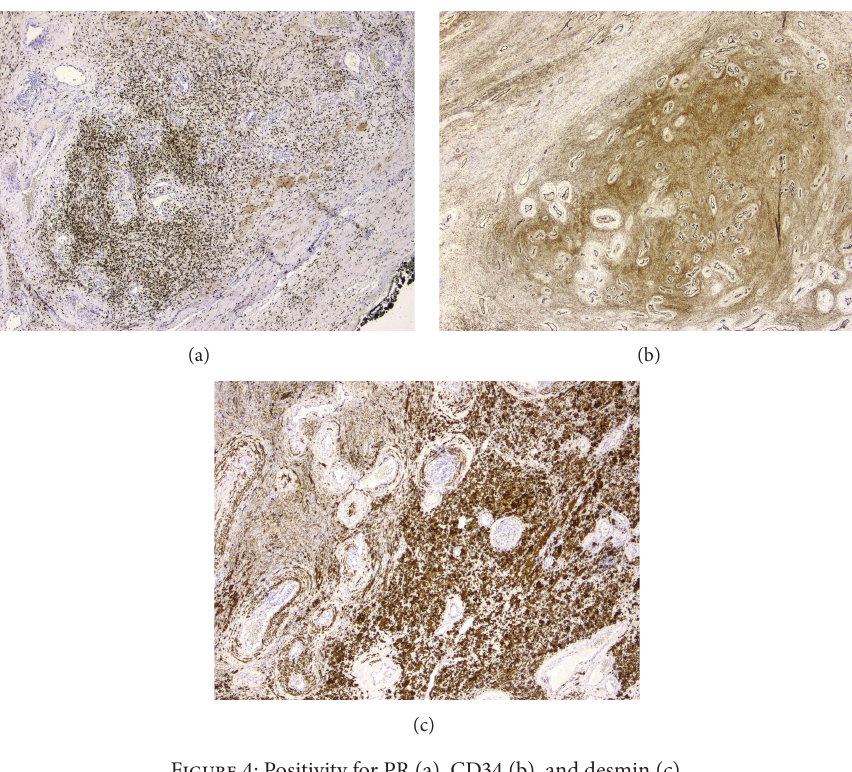
Figure 4: Positivity for PR (a), CD34 (b), and desmin (c).